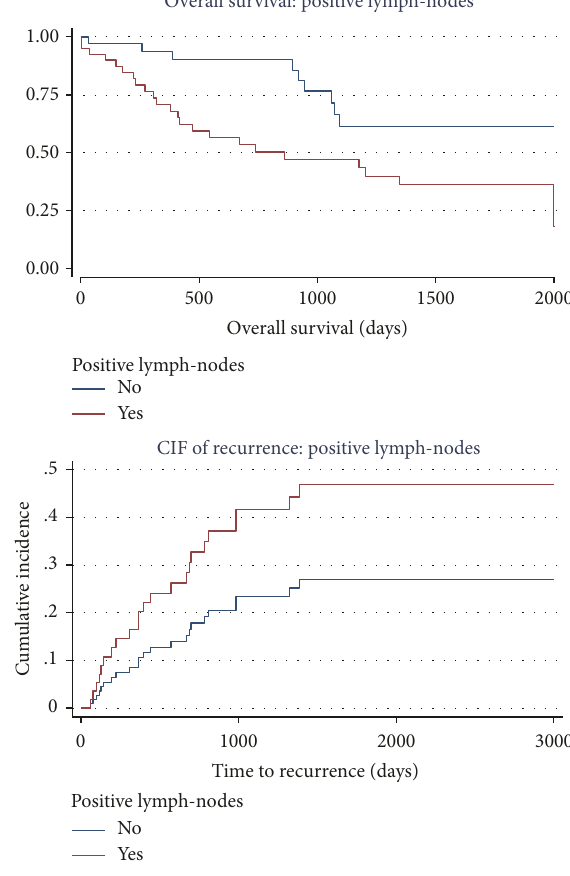
Figure 2: (a) Overall survival: positive lymph-node versus negative lymph-node status. (b) Risk of recurrence: positive lymph-node versus negative lymph-node